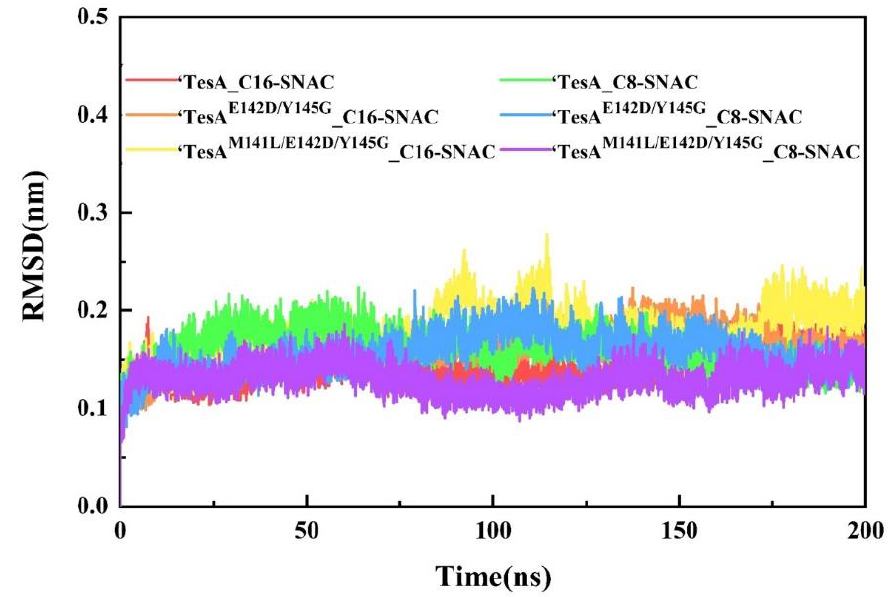
Figure 4. Profiles of the backbone Cα atom RMSD of the six complexes as functions of